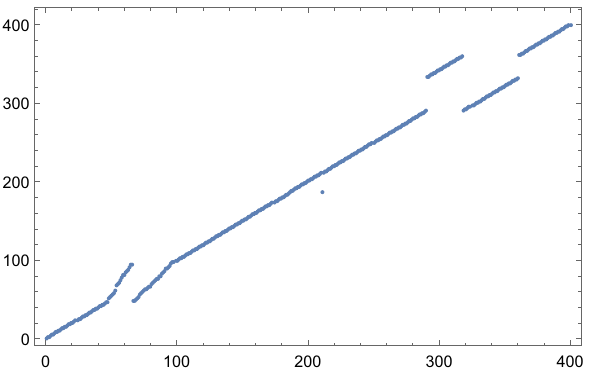
Fig. 12 Minimal and maximal block sizes in various experiments. These variations are result of choosing cluster assignment of each n = 400 . node uniformly at random and independently of all other nodes. Each horizontally aligned point pair corresponds to values in a single experiment, where the horizontal coordinate is the value itself. Blue points are from instances that resulted in high, more than 30 %, error rate in subsequent classification of nodes. The orange points corre- spond to cases when this error rate was less than 1%. Average block n = 500 k = 10 size is 50, following from parameters and . This plot suggests high correlation between error rate and large deviations in block sizes. In case of blue points, the values are roughly twice larger or smaller than the average and in case of orange points the difference is much